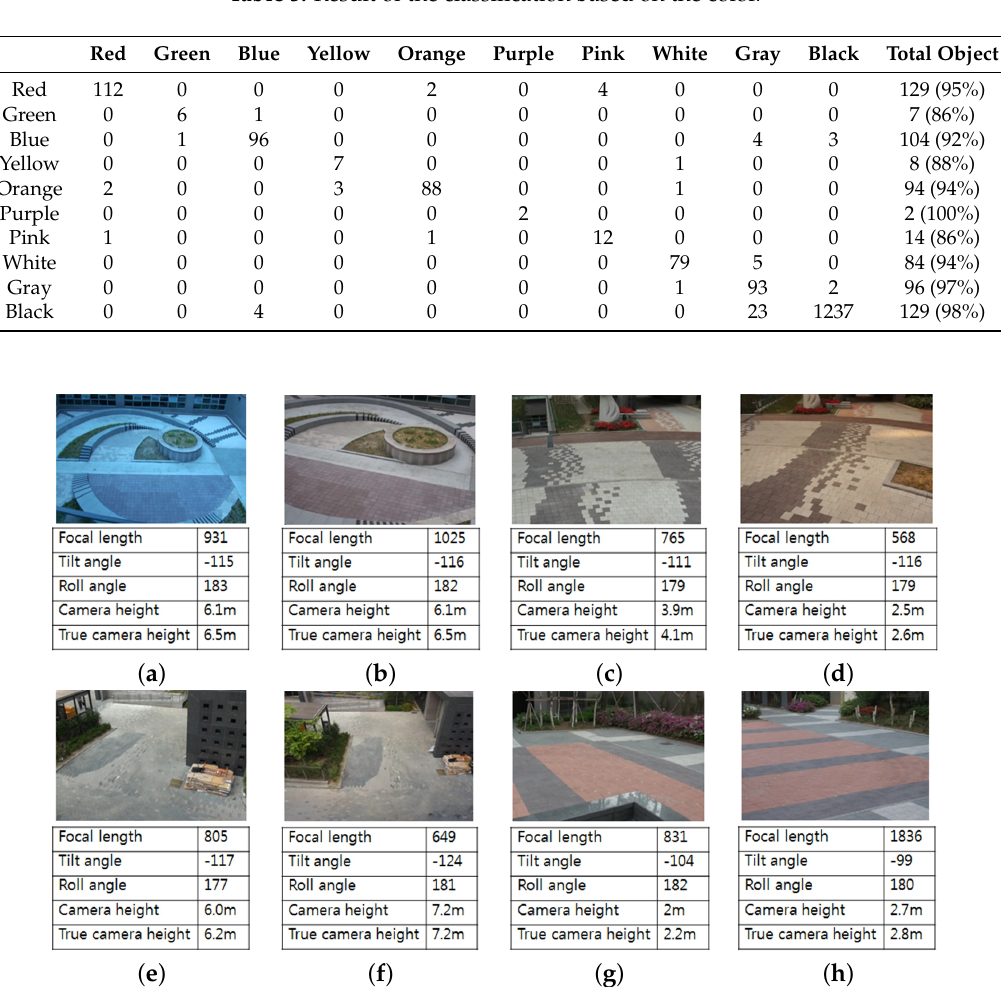
Figure 15. Test video files with estimated camera parameters: ( a , b ) two images of the first scene captured by two different camera parameters; ( c , d ) two images of the second scene captured by two different camera parameters; ( e , f ) two images of the third scene captured by two different camera parameters; ( g , h ) two images of the fourth scene captured by two different camera parameters.